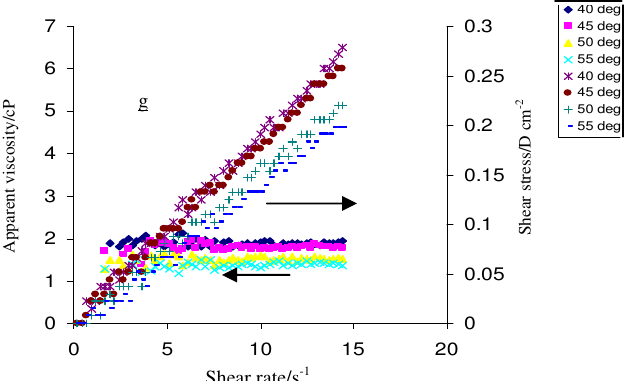
Figure 1. The influence of the shear rate and temperature on the rheological curves of (a) pure chitosan solution; (b) (90/10); (c) 80/20; (d) 70/30; (e) 60/40; (f) 50/50 and (g) pure PVA